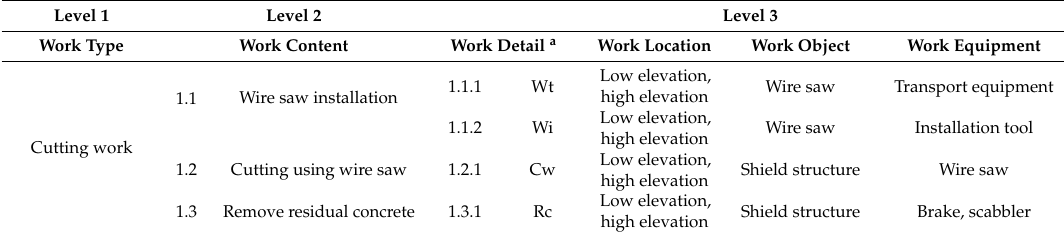
Table 4. Cutting process.